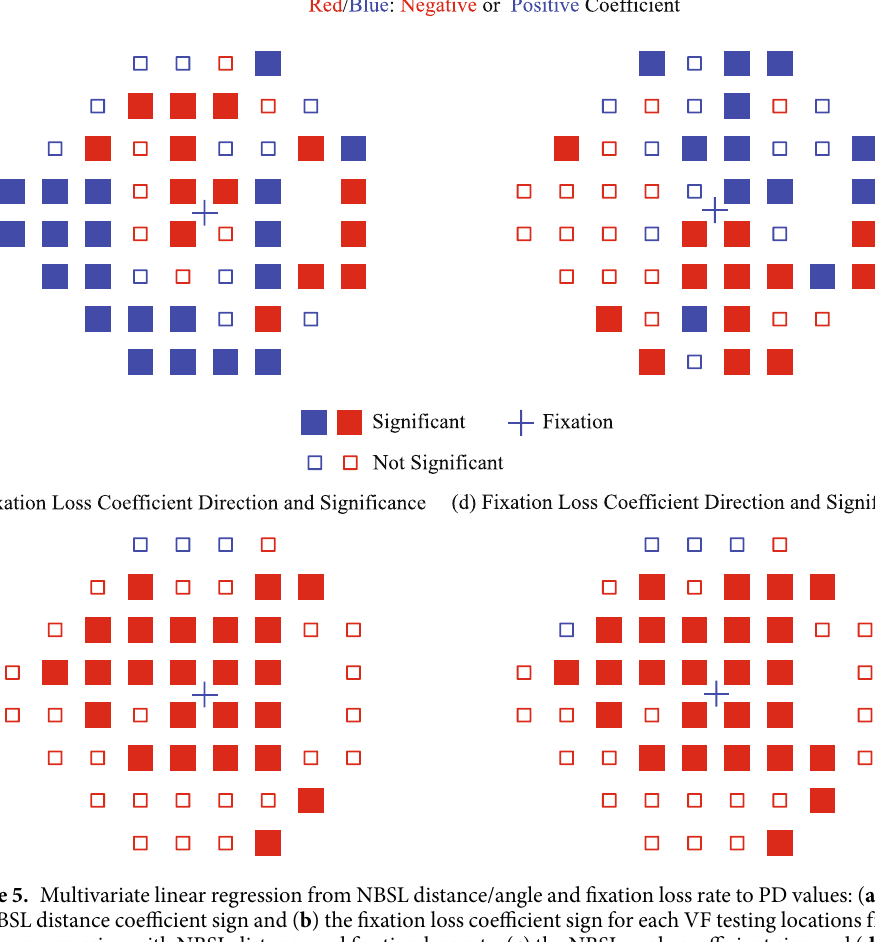
where σ f defines the maximum allowable covariance, γ → are chosen by optimizing the posterior probability of σ f and γ sigma f and γ